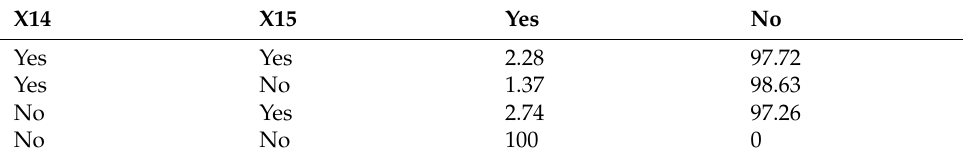
Table A10. Conditional probability of node M7.